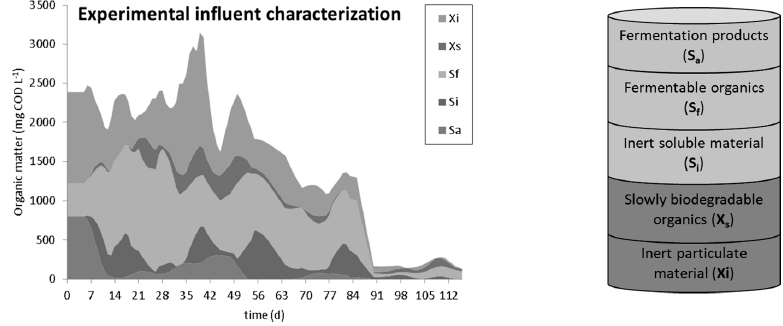
Figure 3. Results of experimental wastewater characterization over time.